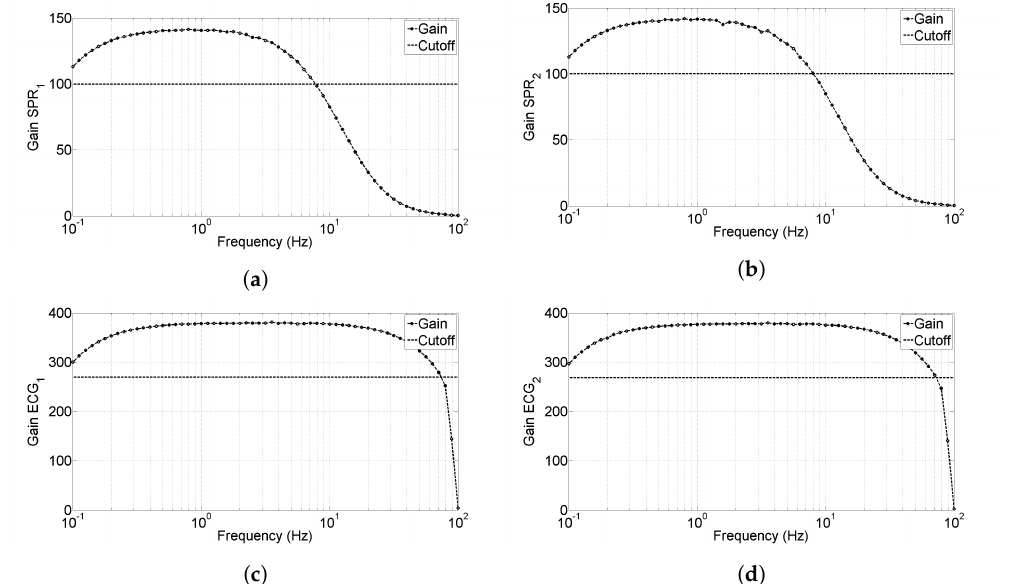
Figure 6. Bandwidth characterization for the developed sensors, horizontal line represents the cut-off limit. ( a ) Bandwidth for SPR 1 signal, ( b ) bandwidth for SPR 2 signal, ( c ) bandwidth for ECG 1 signal, and ( d ) bandwidth for ECG 2